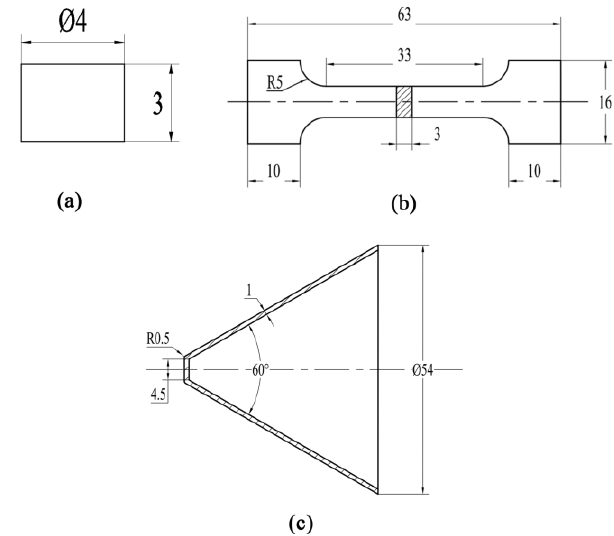
Figure 3. The structure diagram of test samples (unit: mm): ( a ) dynamic/static compression sample, ( b ) static tensile sample, ( c ) liner.